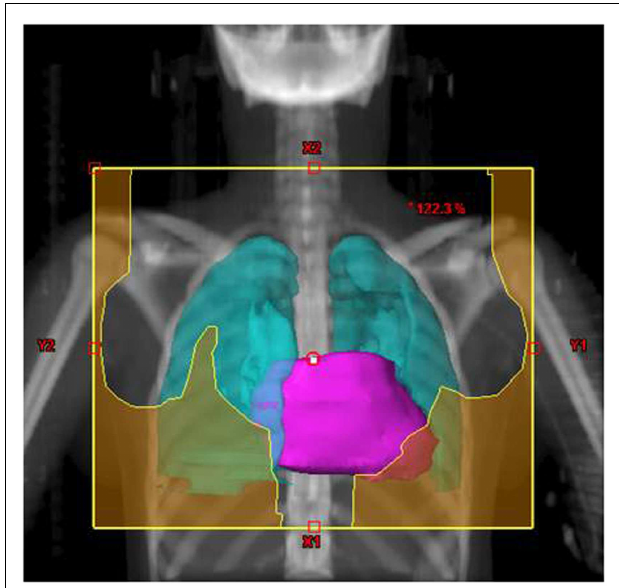
FIGURE 1 |Treatment field definitions forAHOD0031 .